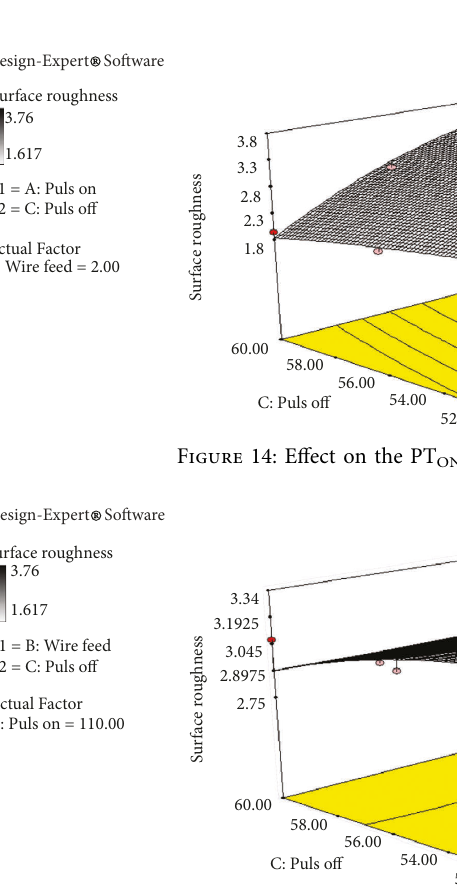
Figure 15: Effect on PT OFF time and WF. Table 8: ANOVA for